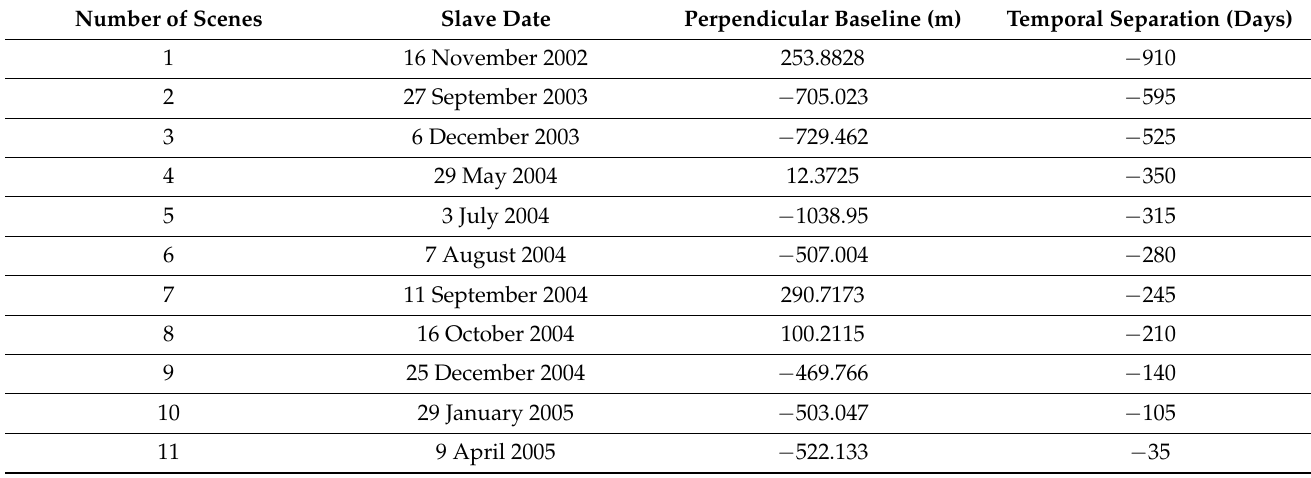
Table 2. Radar data